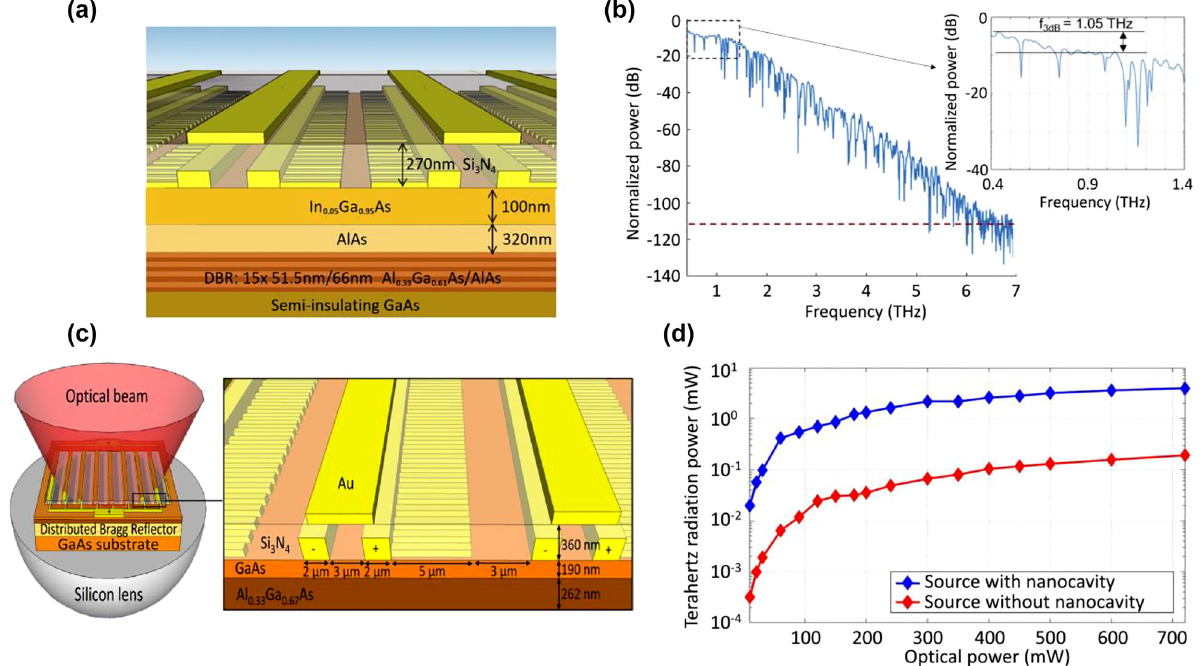
Figure 8: (a) A modified terahertz detector based on plasmonic nanocavities, which is designed to maximize the photo-generated carrier concentration within a 60 nm depth below the plasmonic nanoantennas. (b) The frequency-domain power spectrum obtained with this detector at 0.1 mW optical pump power level. Adapted from [49]. (c) A terahertz emitter based on plasmonic nanocavities and (d) its radiation power compared with a plasmonic nanoantenna array based on a short-carrier-lifetime LT-GaAs photoconductor as a function of the optical pump power. Adapted from